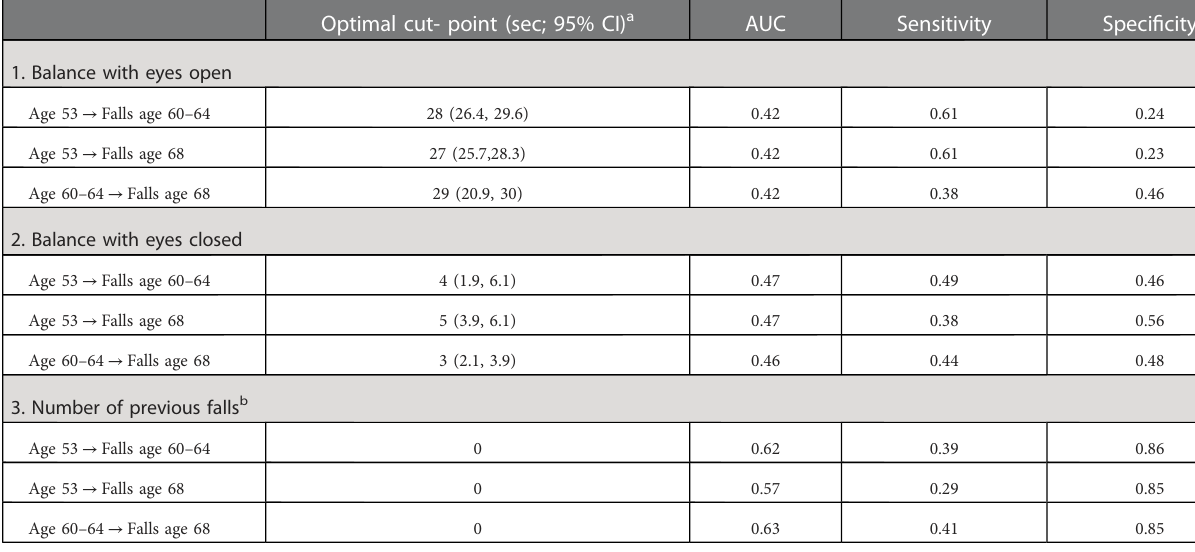
TABLE 1 Identifying optimal cut-points for the one-legged balance test (and number of previous falls) in predicting recurrent (0 – 1 vs. 2+) falls using the Liu